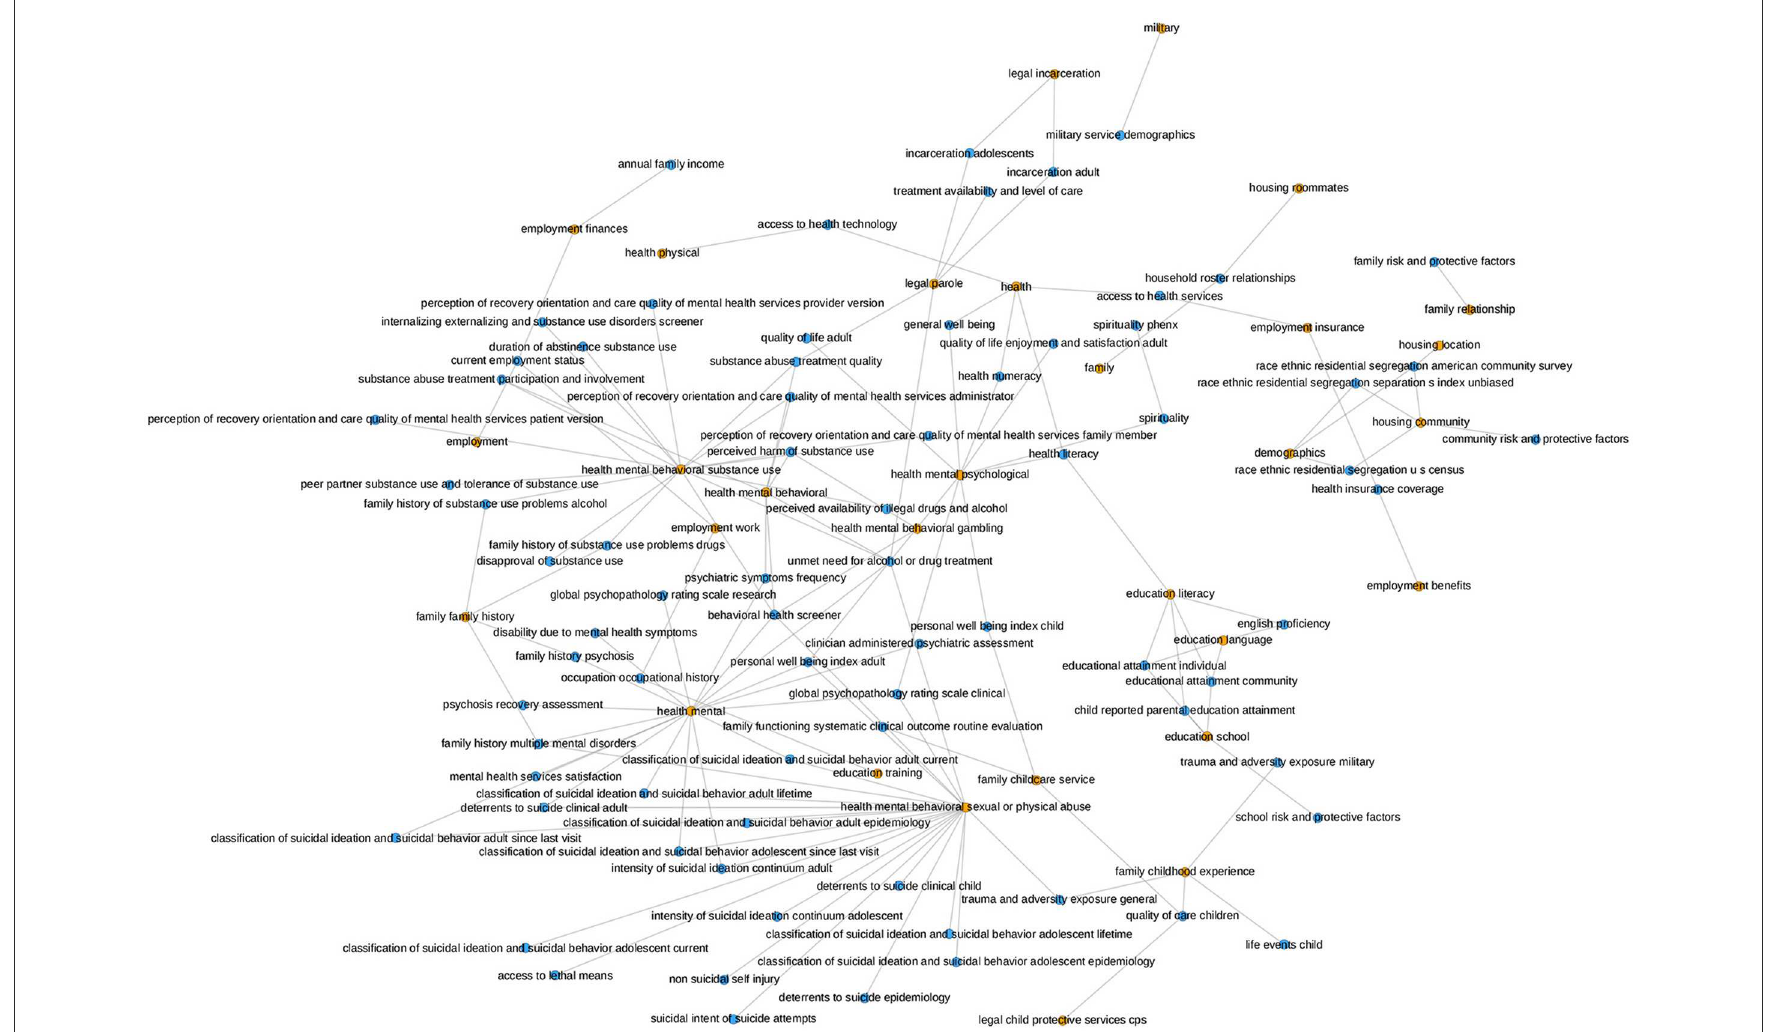
FIGURE8 This graph illustrates the mapping of the PhenX SDOH Toolkit Protocol Names to the SDOH categories in our data. The orange nodes represent the SDOH categories in our data and the blue nodes represent the PhenX categories. The mapping was generated by comparing the cosine similarity between the names of the Protocols and the names of the SDOH categories in our dataset. The presence of an edge between a blue node and an orange node signifies that the PhenX category and the SDOH category in our data were found to be semantically similar according to the cosine similarity. The occurrence of many connections from one SDOH category in our dataset to several PhenX data categories indicates that our category is determined to be comparable to more than one category in the PhenX